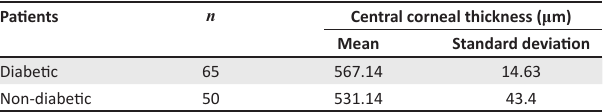
TABLE 1: Mean Central corneal thickness in microns ( μ m) of diabetic and non-diabetic patients.